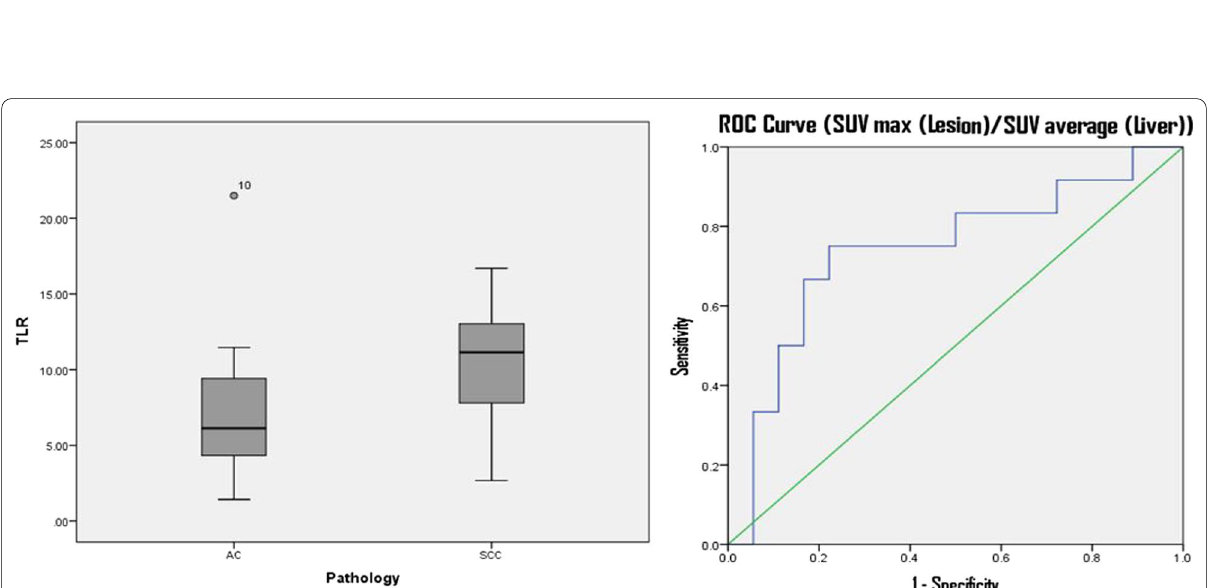
Fig. 7 Comparison of TLR between AC and SCC. ROC curve of the tumor-to-liver ratio (TLR) concerning the histopathology of the